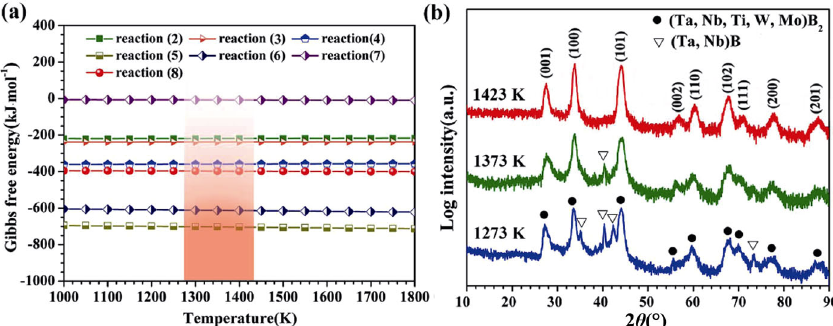
Fig. 1 (a) Thermodynamics analysis of the possible chemical reactions for the as-synthesized HEB-1 products; (b) XRD patterns of the as-synthesized products at different temperatures.